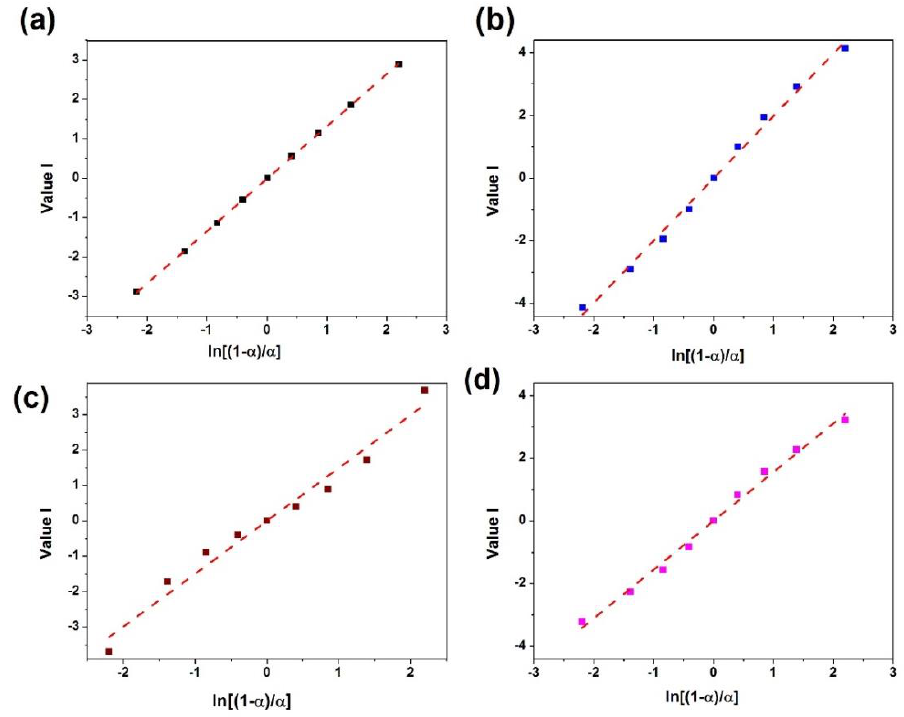
Figure 10. Plots of ValueI calculated using DSC data for ( a ) neat epoxy, ( b ) epoxy/P-HNT, ( c ) epoxy/A-HNT and ( d ) epoxy/F-HNT.